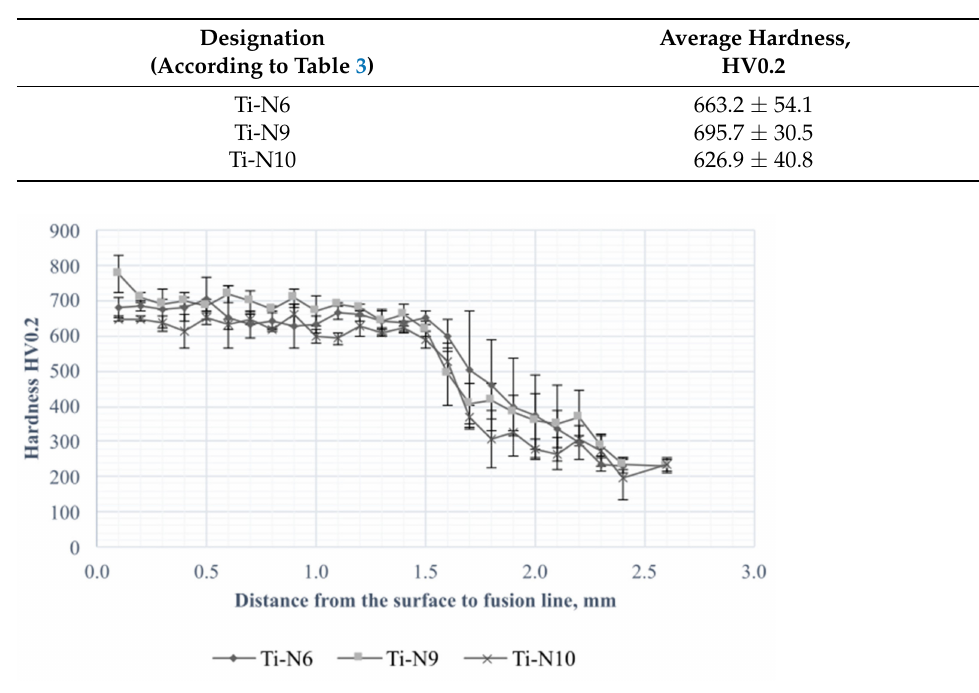
Table 6. The average Vickers hardness results of homogeneous laser-alloyed surface layers.